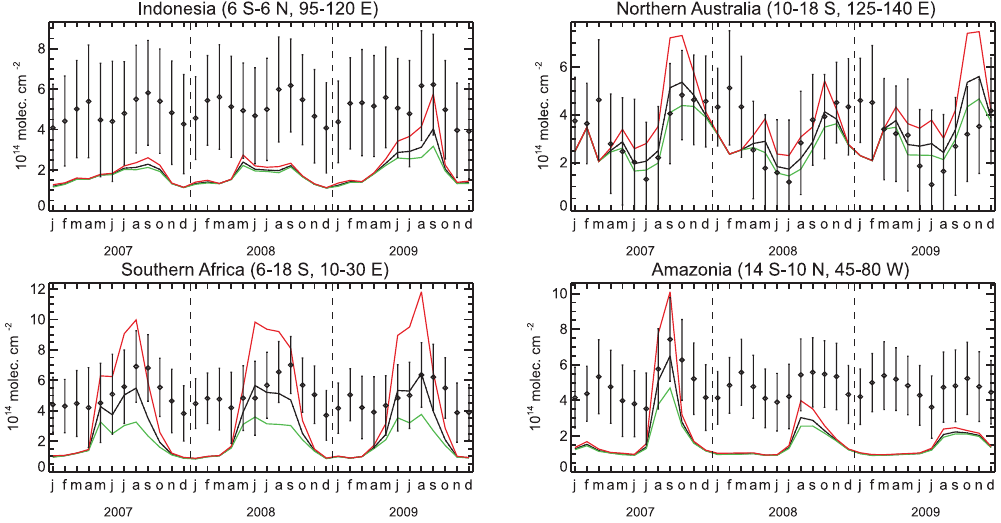
Fig. 13. Modelled and observed glyoxal column time series for selected tropical regions. The lines represent the standard simulation (in black) and the simulations with halved (S3 – in green) or doubled (S4 – in red) biomass burning emissions of glyoxal and its